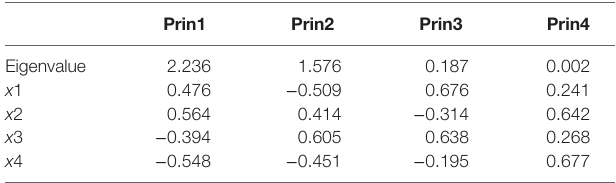
TABLe 5 | eigenvalue and eigenvactor for Hald’s data.